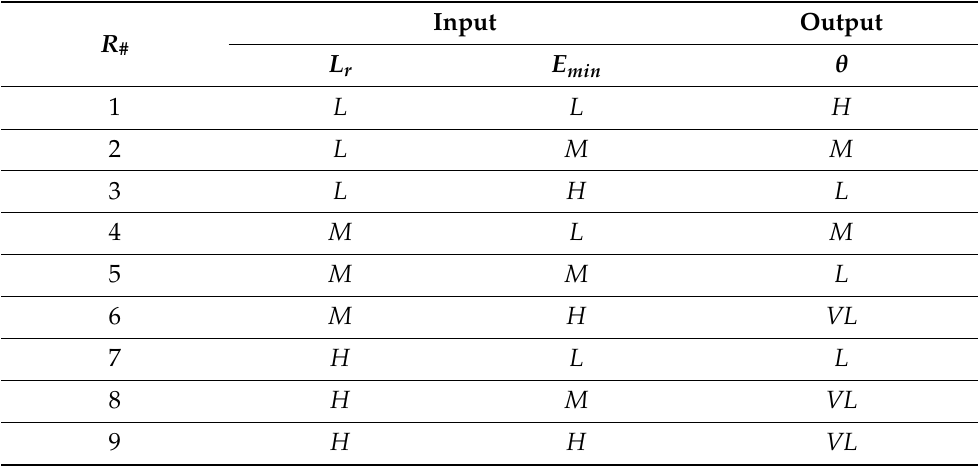
Table 4. Fuzzy rules for safe energy level